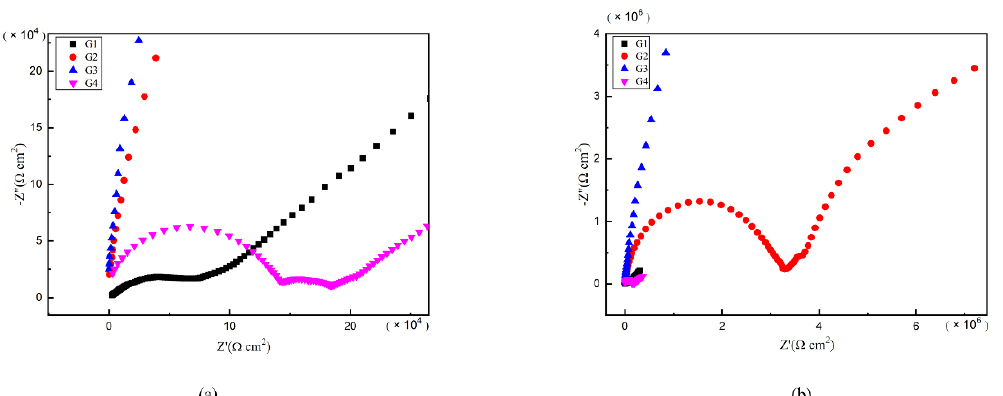
Figure 7. Each EP/CeO 2 -GO coating’s Nyquist pattern for immersion for 8 d: ( a ) Nyquist patterns for 8 d; ( b ) amplification of Nyquist patterns for 8d.